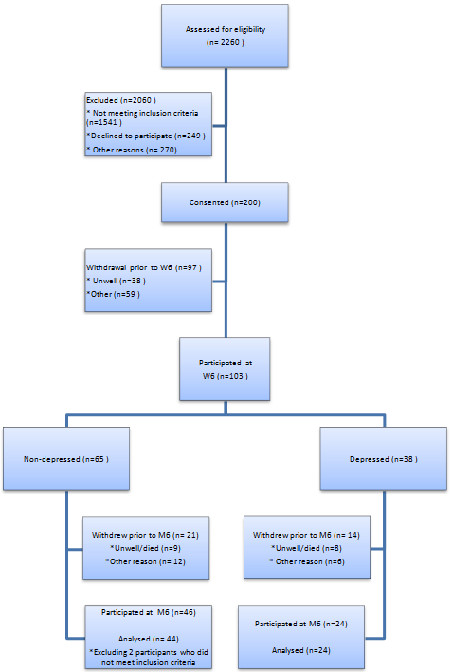
Consort diagram showing recruitment rates.